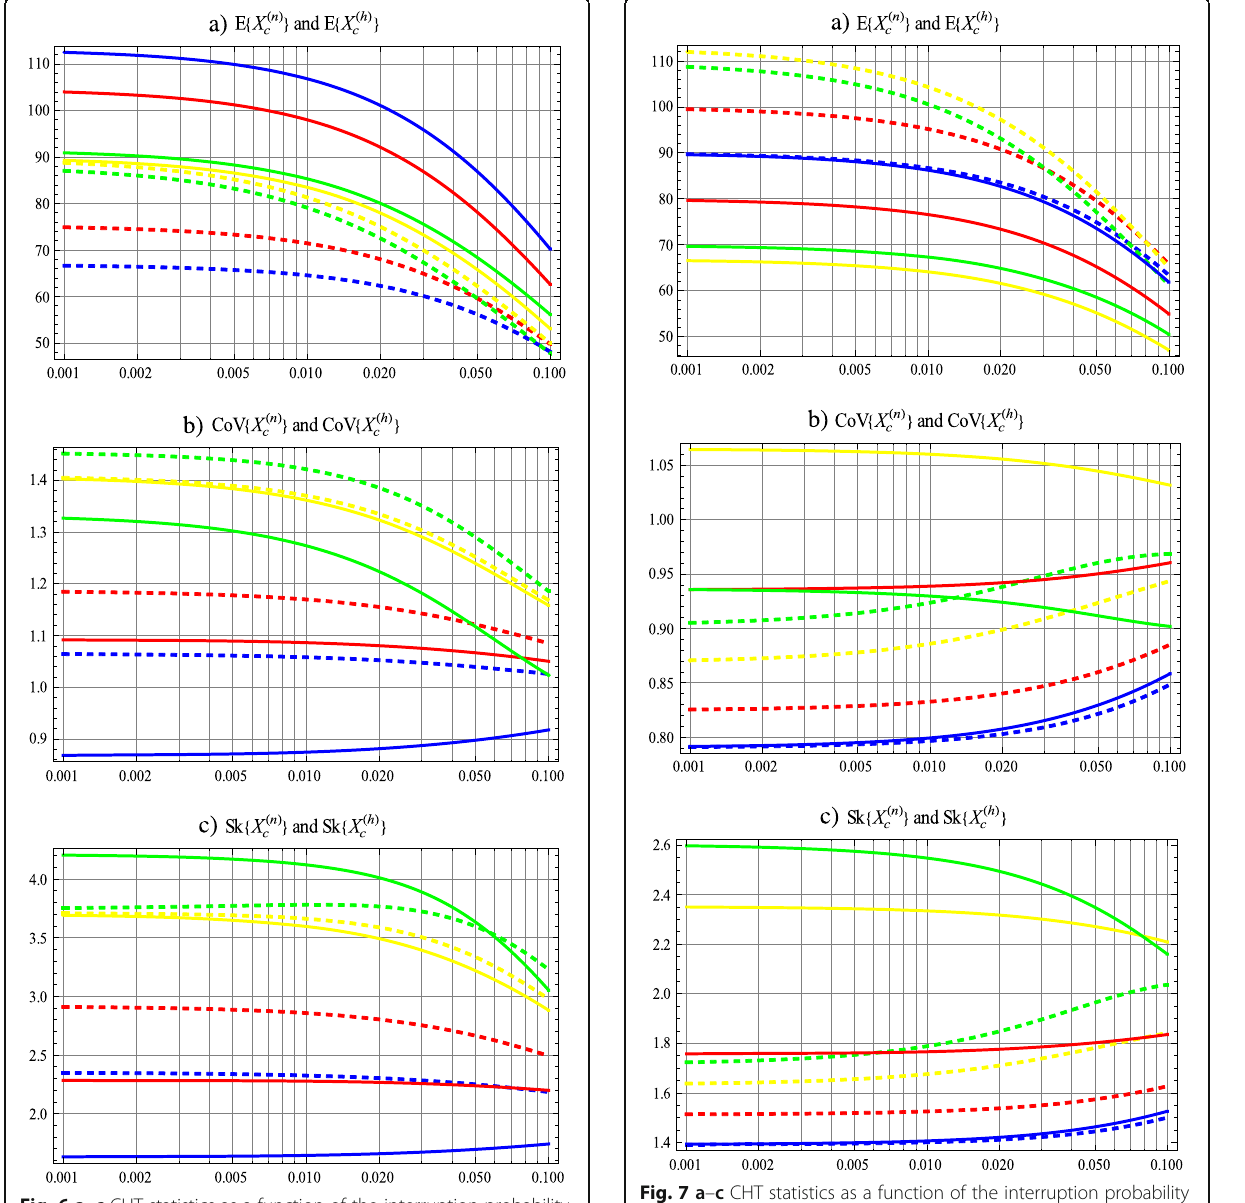
for different distributions of the UST when CDT is hyper-exponentially distributed. In this figure, red , blue , yellow , and green lines represent the scenarios where the UST is exponentially, Erlang, hyper-exponentially of order 2, and hyper-Erlang of order (2, 2) distributed, respectively. Solid-lines ( dashed-lines ) corresponds to CHTn (CHTh) statistics